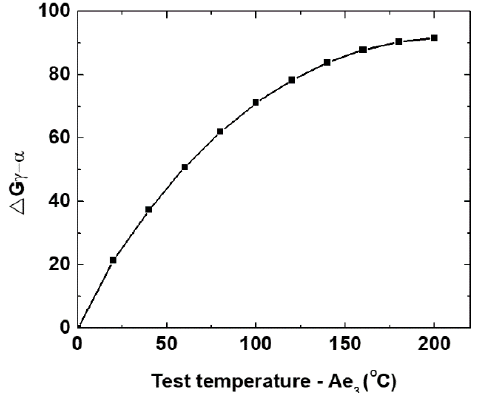
Figure 2. The free energy difference between the austenite and ferrite calculated using the FactSage thermodynamic software employing FSstel database. Note that the starting temperature is the Ae 3 . Metals 2018 , 8 , x FOR PEER REVIEW